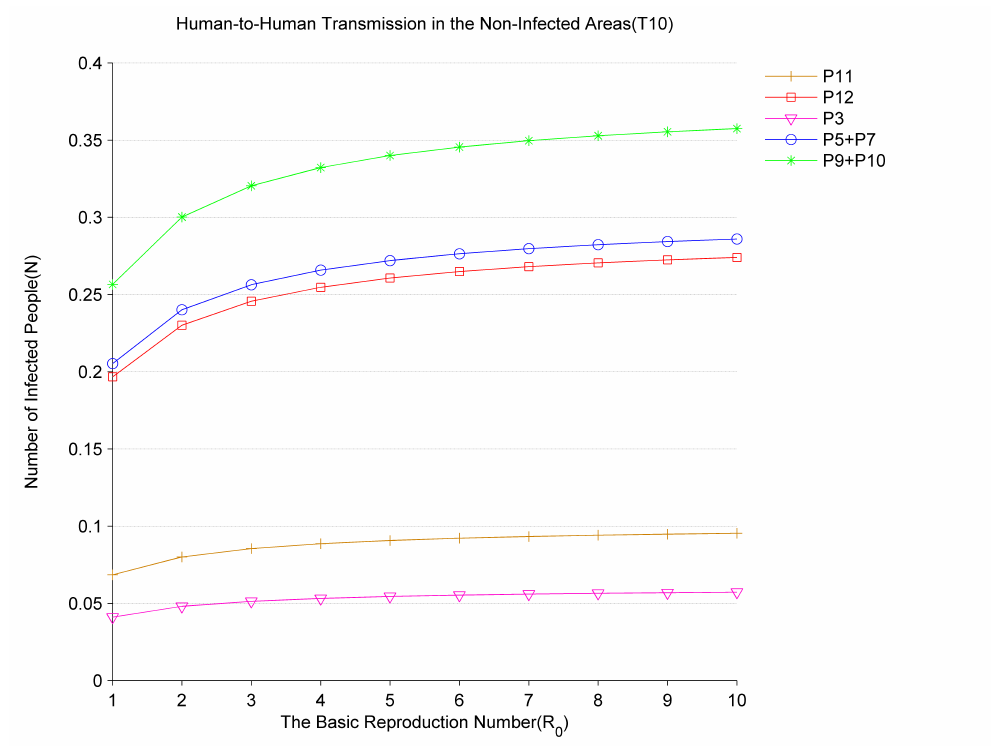
Figure 9. Relationship between the basic reproduction number ( R 0 ) and the number of infected people in the non-infected areas.